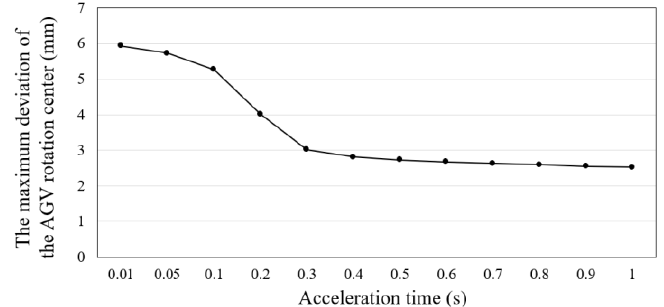
ff erent acceleration